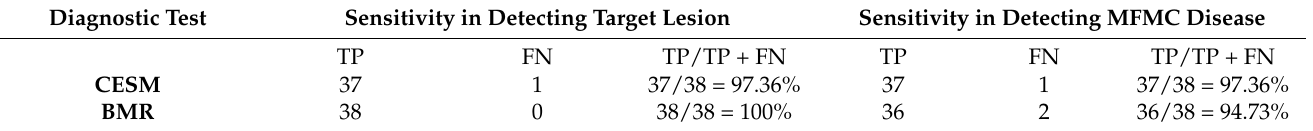
Table 2. CESM and BMR